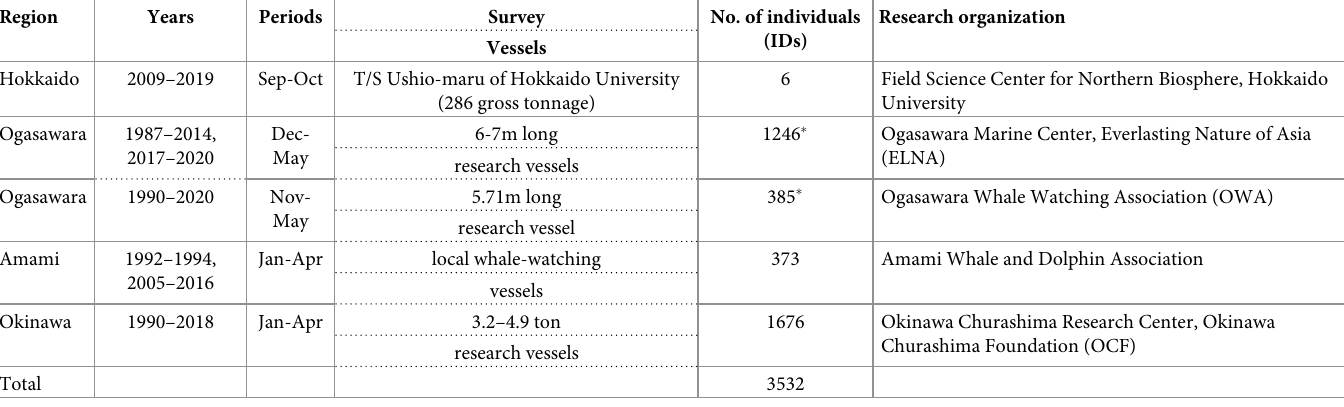
Table 1. Study years, periods, vessels, and number of individuals (IDs) obtained from each of the sighting region.